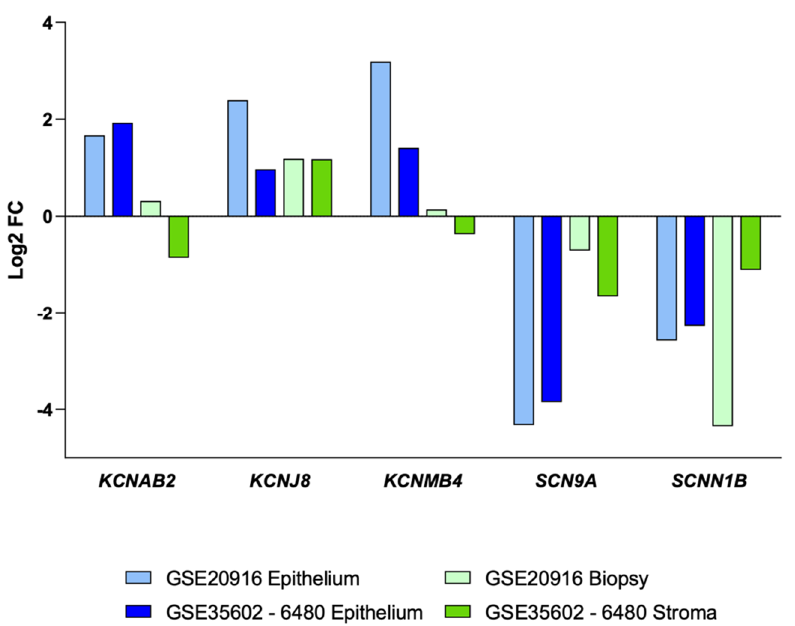
Figure 7. Log 2 fold change profiles of genes selected as potential targets from different colon CRC tissues compared to their respective healthy control tissues. Data were obtained from the following databases: GSE20916 ( n = 60 macro-dissected, n = 30 micro-dissected samples representing carcinoma and control groups) and GSE35602-6480 ( n = 34 micro-dissected samples representing CRC and control groups) [32]. Log 2 fold change ≥1.5 or ≤−1.5, with p < 0.05, were considered for CRC